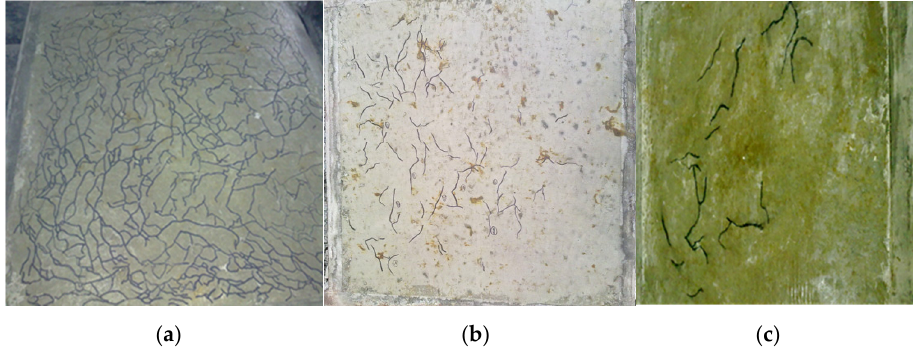
Figure 8. Crack morphology of some specimens after (Tcr + 27.5) hours (normal FACs + 10% CaO).